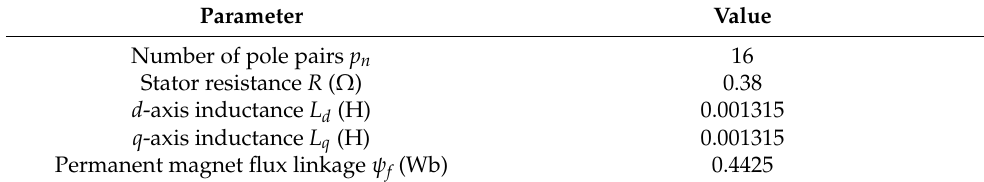
Table 1. The parameters of the